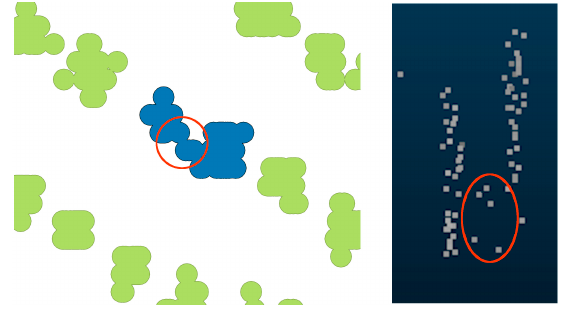
Figure 9. False negative due to a merge of buffers.